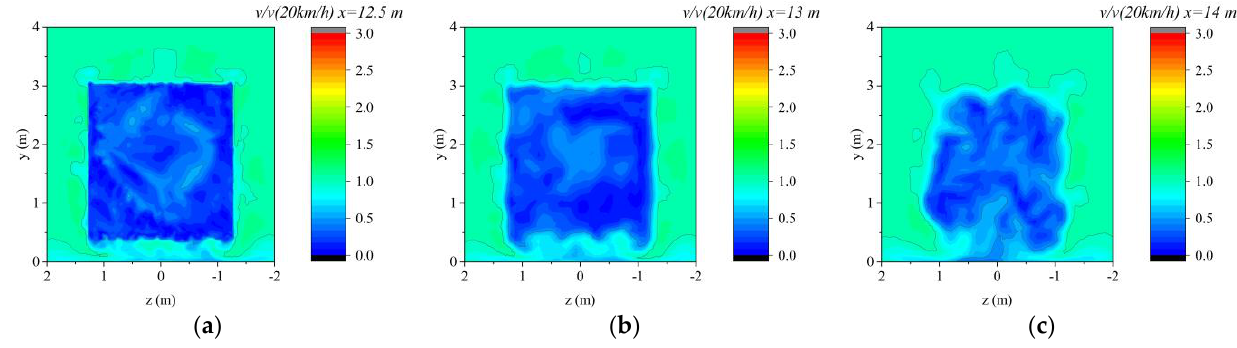
Figure 12. Velocity distribution at ( a ) x = 12.5 m, ( b ) 13 m, and ( c ) 14 m y – z vertical sections.